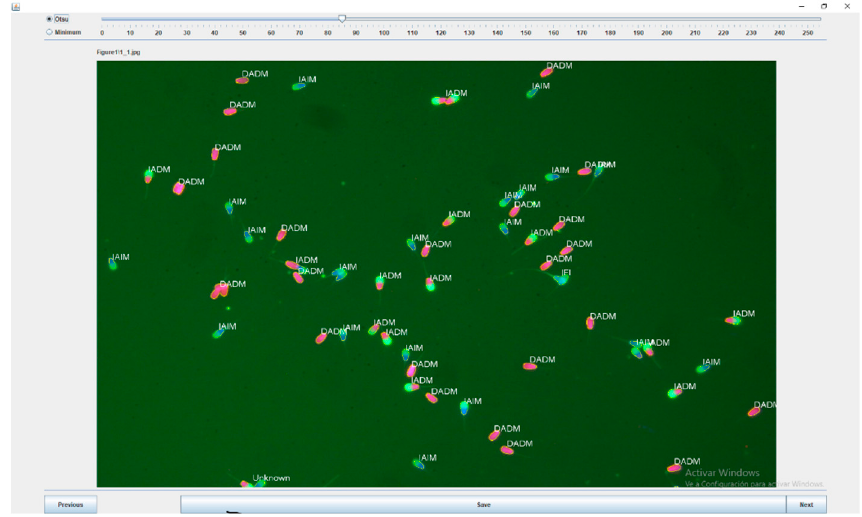
Figure 4. Sperm functionality module output, showing the spermatozoa classification in IAIM (Intact Acrosome and Intact Membrane), IADM (Intact Acrosome and Damaged Membrane), DAIM (Damaged Acrosome and Intact Membrane), DADM (Damaged Acrosome and Damaged Membrane) and IFI (Increased Fluorescence Intensity).